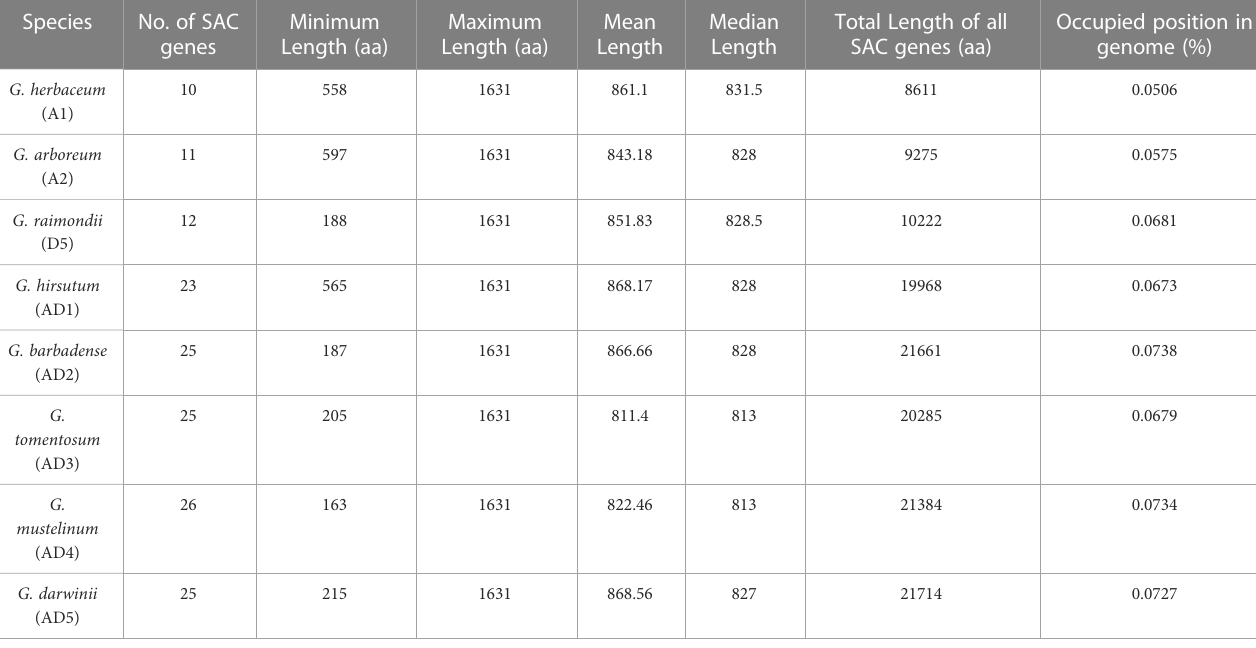
TABLE 1 Features of cotton SAC